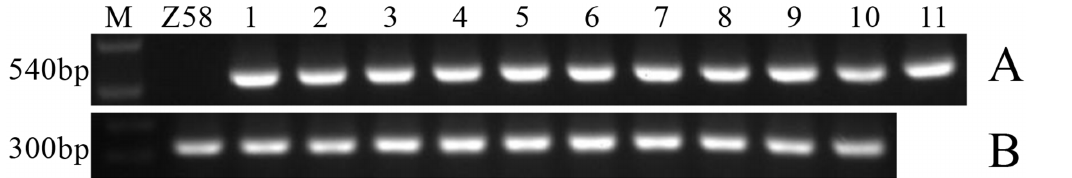
Fig 2. PCR analysis of aga-F75m (A) and actin (B) in the transgenic maize leaves of transformation event 8 – 1. Lanes: M, the DNA molecular weight markers; Z58, the non-transgenic Zheng58; 1 – 10, the transgenic plants; 11, the aga-F75 as the positive control.